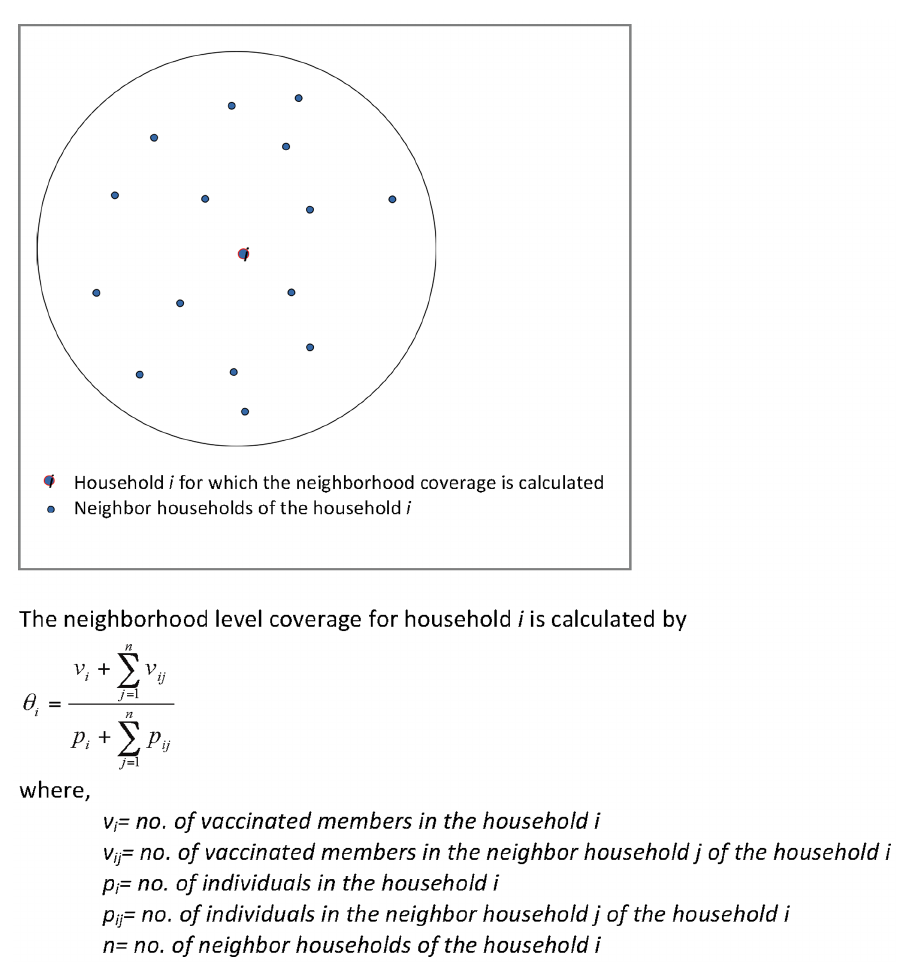
Figure 1. Computation of neighborhood level vaccine coverage using a Geographic Information System approach.